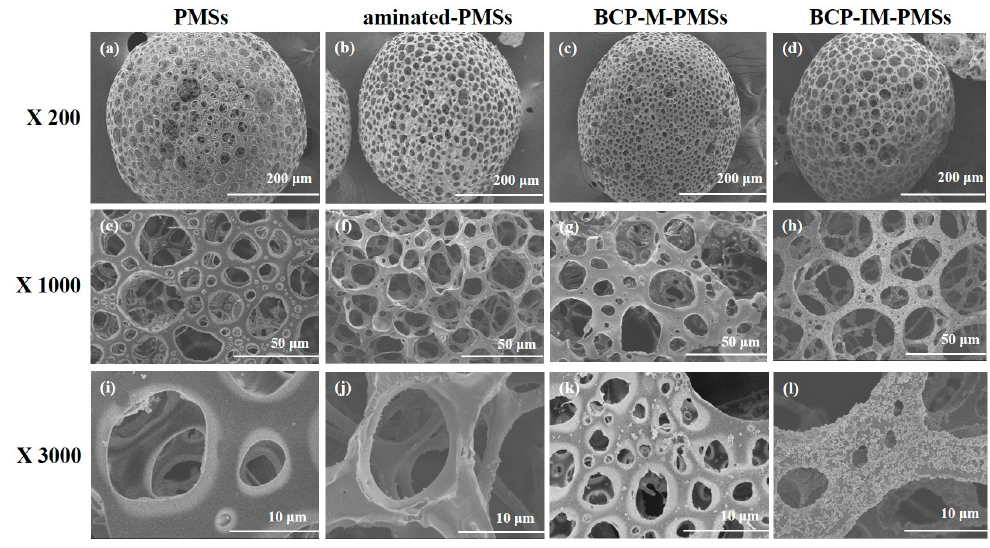
Figure 2. Scanning electron microscope (SEM) images of porous microspheres (PMSs) ( a , e , i ),